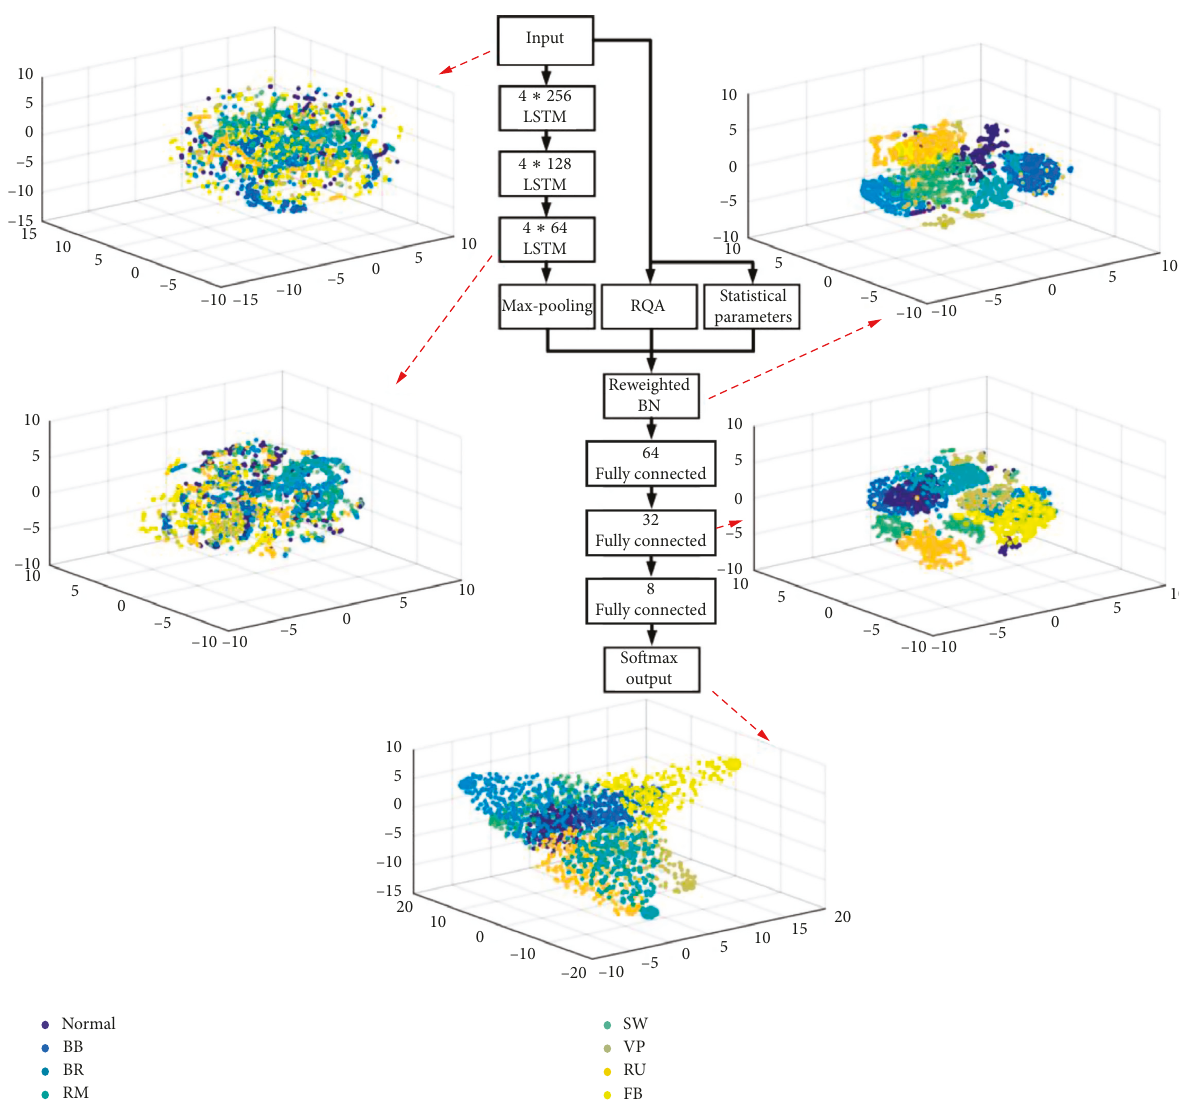
Figure 12: 3D representations of high-dimensional outputs at different layers with dataset 1 by